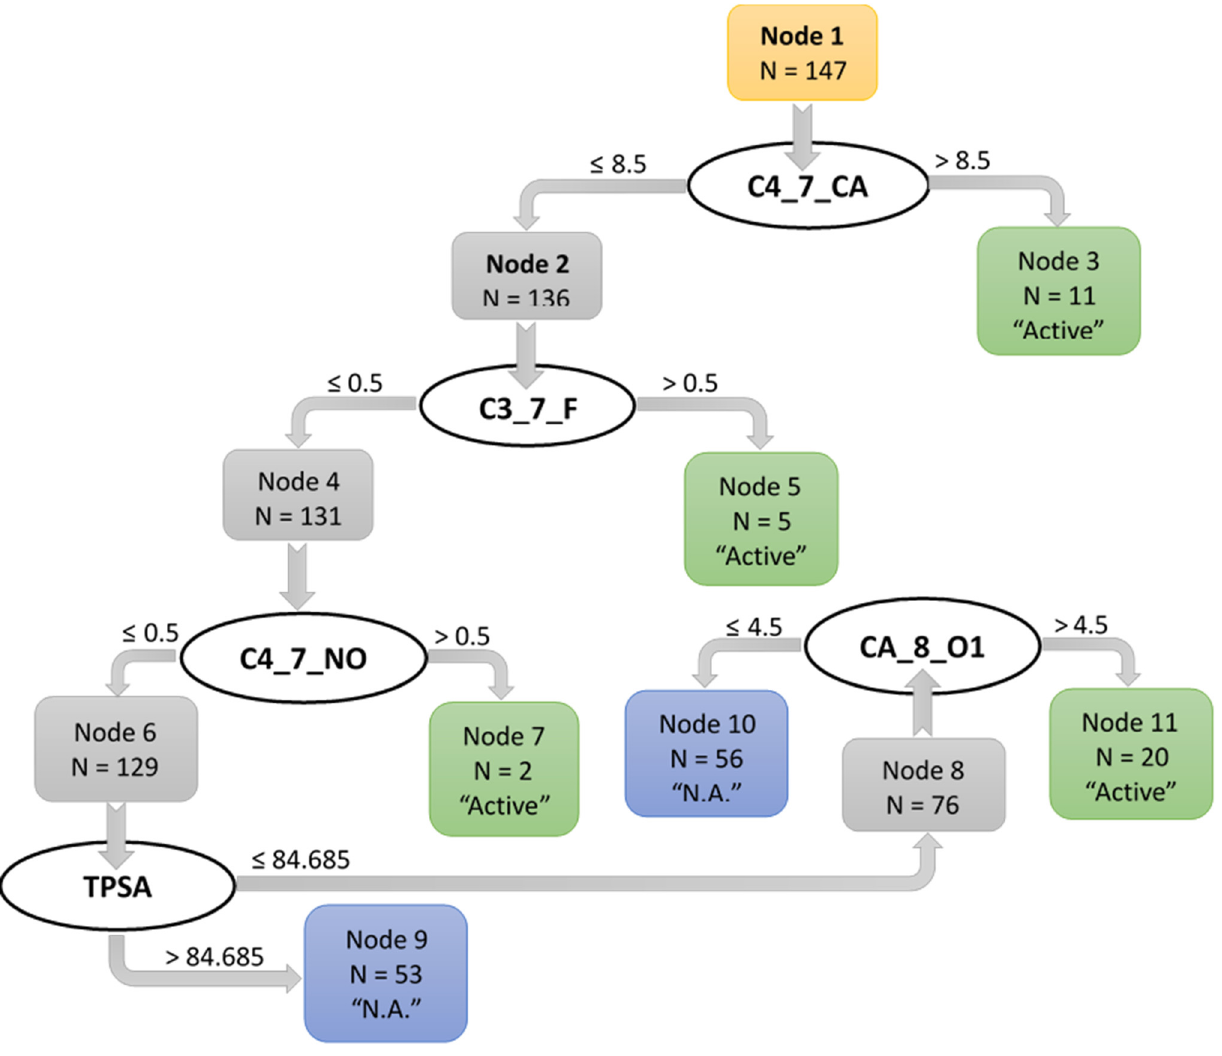
Figure 4. A binary classification tree reflecting the simplified SAR rules for predicting the inhibition of the NF- κ B transcription activity by pyridazinones and related derivatives.